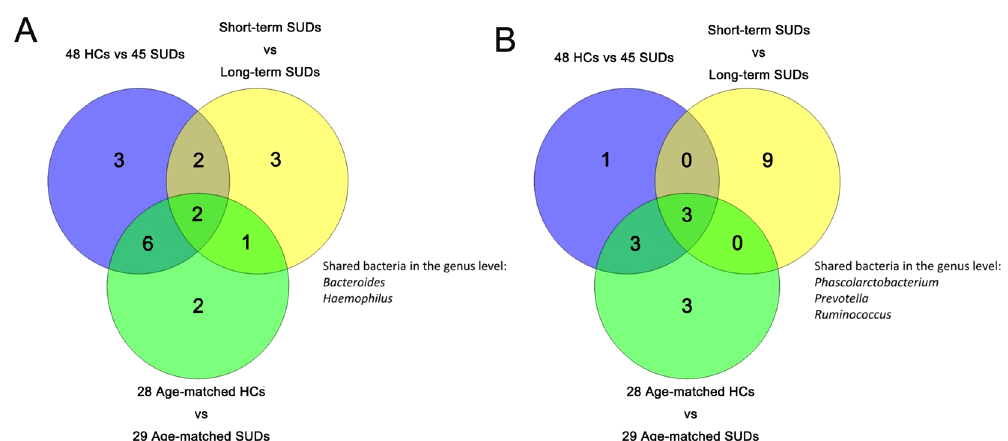
Figure 3. Three-group shared bacteria in the VENN. Bacteria from Bacteroides , and Haemophilus ( A ) were consistently less abundant whereas the number of bacteria from Prevotella , Phascolarctobacterium and Ruminococcus ( B ) were consistently increased in SUDs vs HCs, and in long-term SUDs vs short-term SUDs.